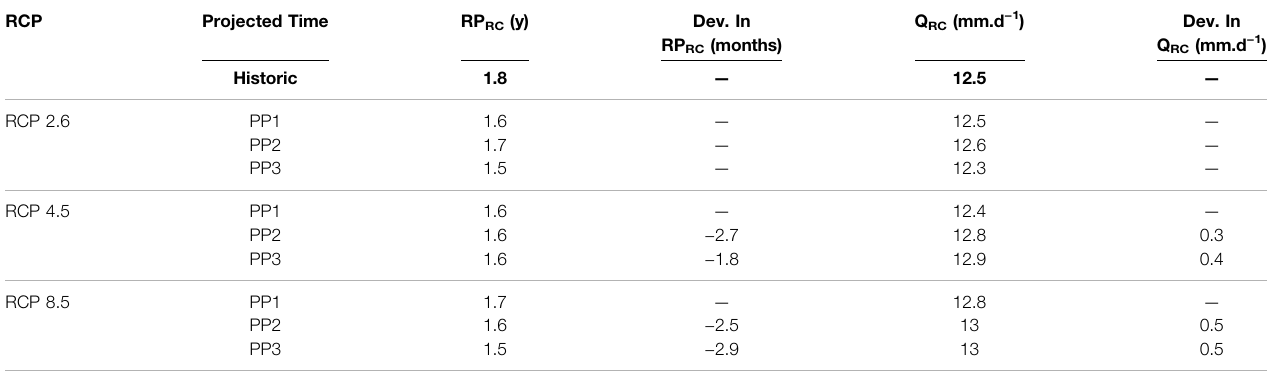
TABLE 7 | Evolution of the return period in the regime change RP RC and the corresponding discharges Q RC in the projected future for the three RCPs. The deviations (Dev.) for RP RC and Q RC were only calculated when the deviations from the historical period to the future were signi fi cant, i.e. when the con fi dence intervals were not superimposed close to the regime change in the